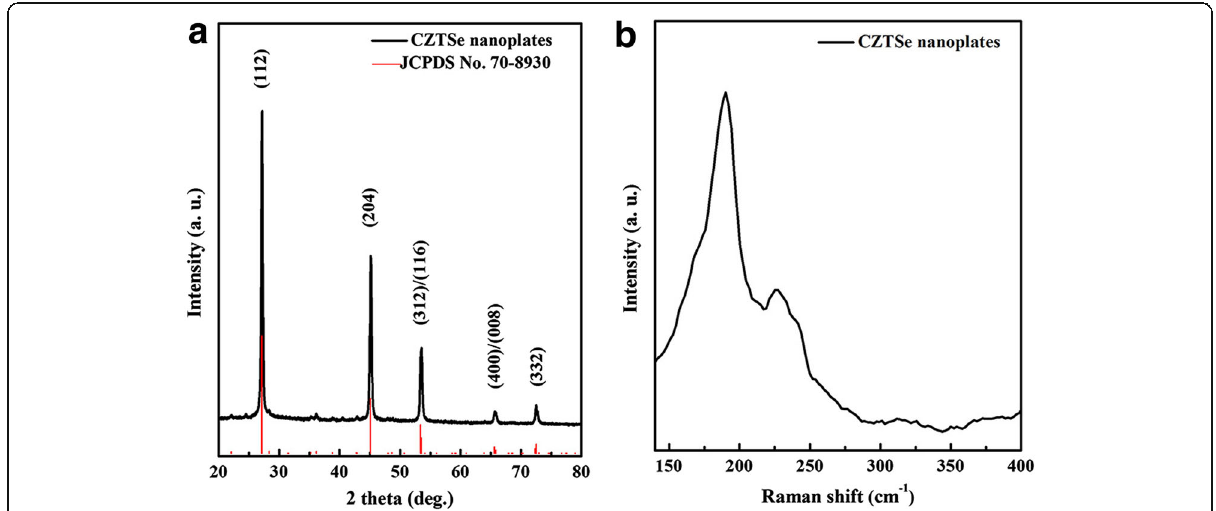
Fig. 1 a XRD pattern and b Raman spectrum of CZTSe